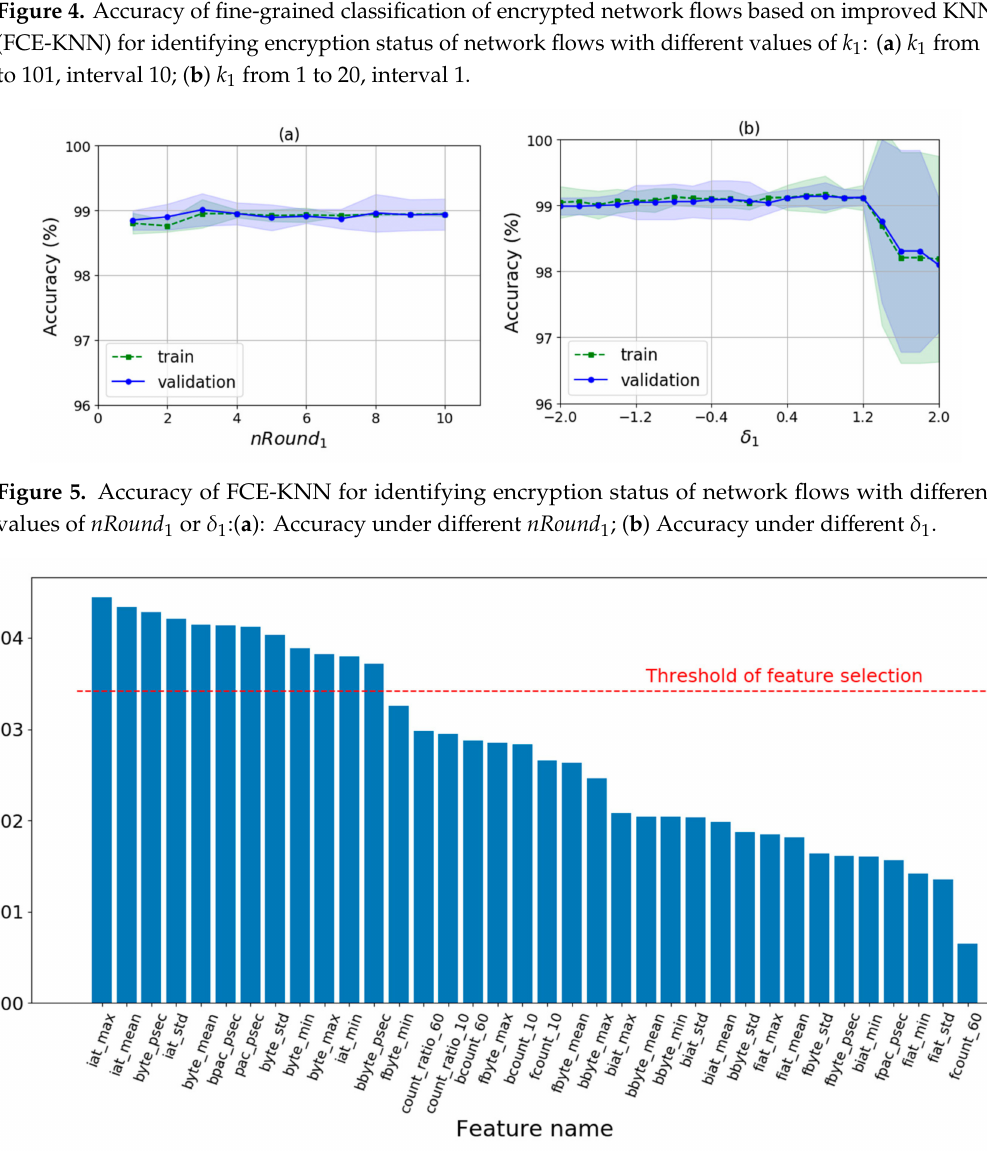
Figure 6. Comparison of feature weights in the feature selection part of the model training for identifying encryption status of network